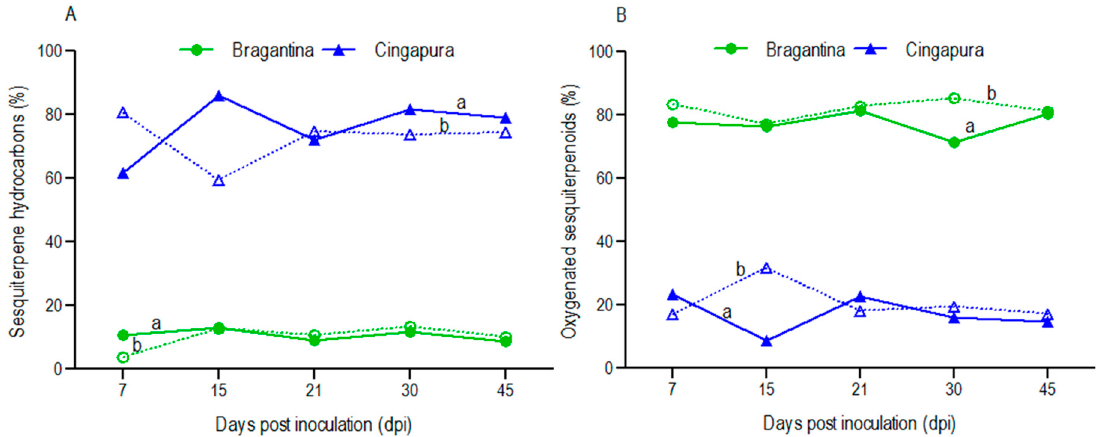
Figure 2. Sesquiterpenes variation in P. nigrum cultivars during infection by F. solani f. sp. piperis . ( A ) Sesquiterpenes hydrocarbons; ( B ) Oxygenated sesquiterpenes; (a) inoculated plants; (b) control plants. dpi: days post infection.